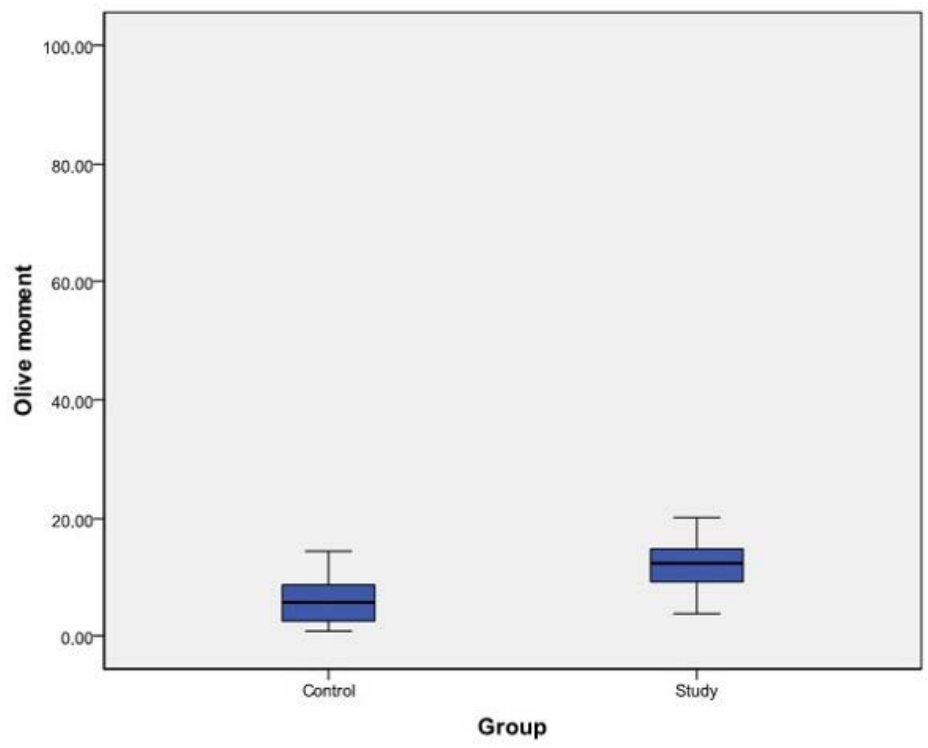
Figure 1. Tail moment ranges and mean differences between the study and control groups.